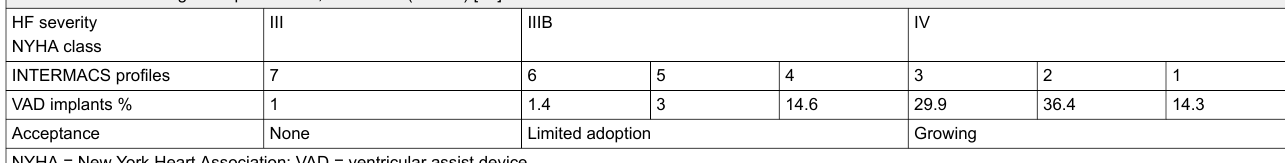
Table 2: INTERMACS classes and optimal timing for mechanical circulatory support. Data from: Kirklin JK, et al. Sixth INTERMACS annual report: A 10000-patient database. J Heart Lung Transplant. 2014;33:555–64 (table 7)